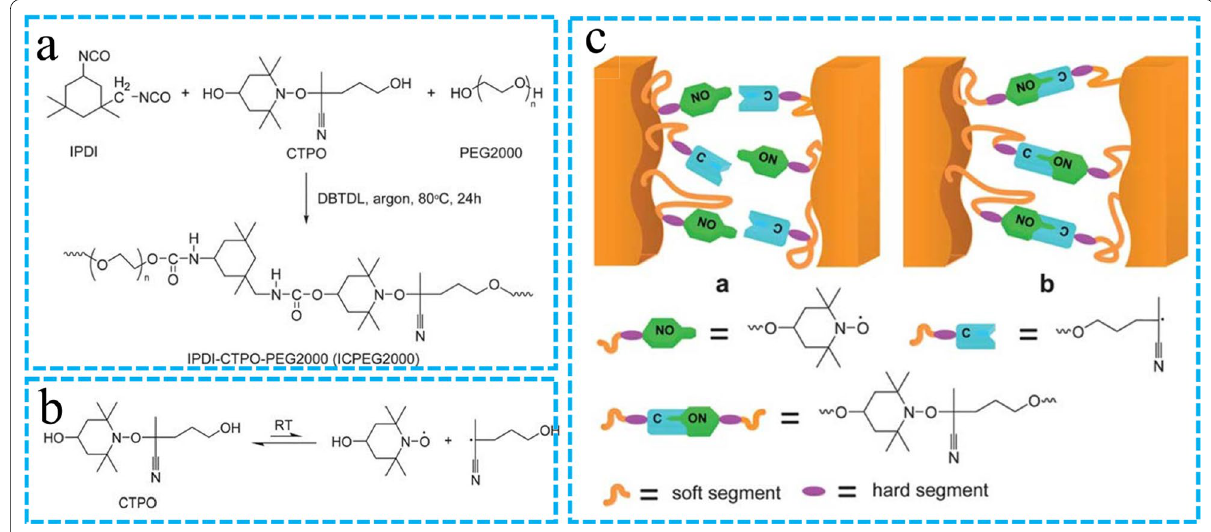
Fig.7 a Synthetic route of the ICPEG2000. b Dissociation/as-sociation of the a CTPO diol monomer. c Schematic diagram of the healing mechanism. Reprinted with permission form Reference [29]. Copyright 2013, Royal Society of Chemistry